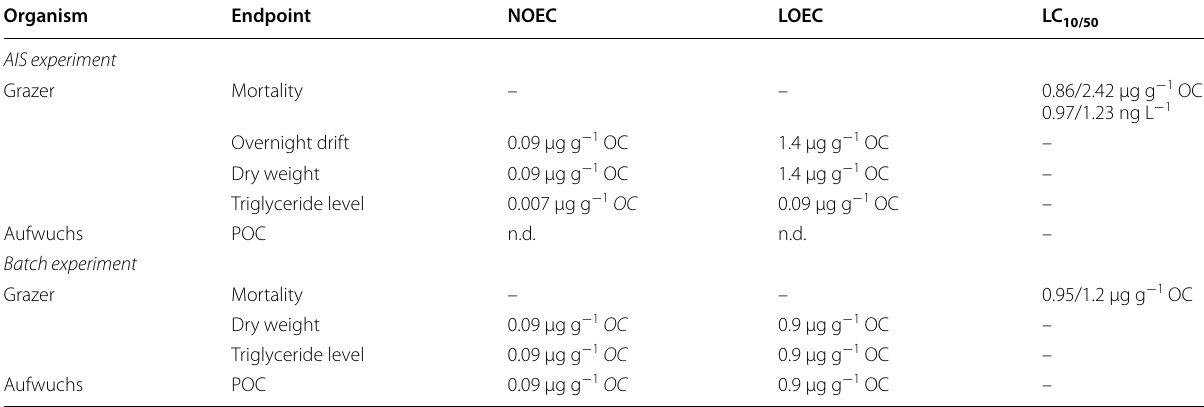
Table 7 Deduced effect concentrations of LCH during the AIS and batch experiments of the different test organisms and observed